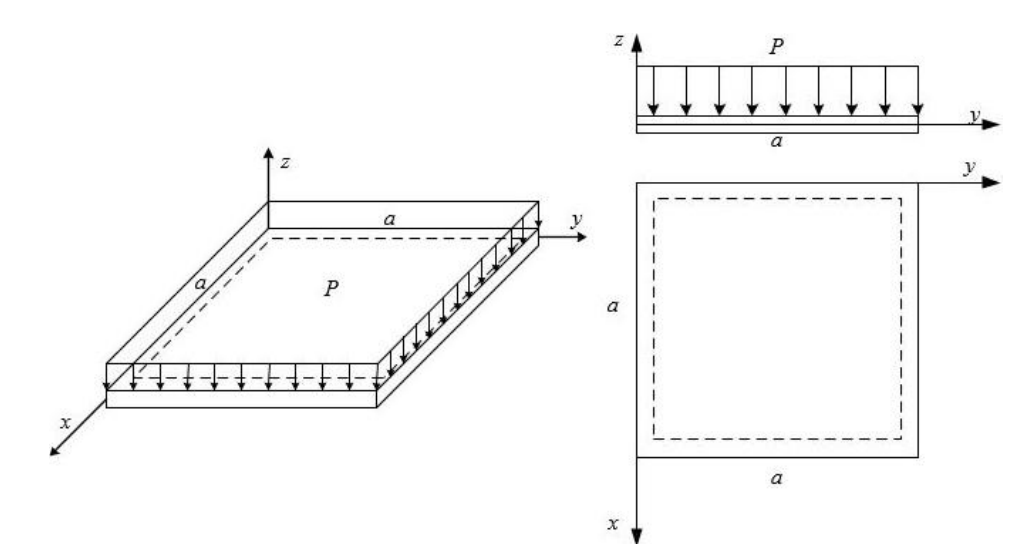
Figure 2. Schematic representation of coordinate system, loads, and supports applied to the plate. The plate domain was discretized using 17 × 17 Lagrangian four node elements (Q4) and nine node elements (Q9), and the plate was submitted to a constant unit pressure of 10 4 Pa. The study was conducted for three aspect ratios ( a / h = 5, 10, and 20, where ( a ) is the plate edge dimension ( a = 1 m), and ( h ) stands for the thickness. The power exponent p used, was 7. The results obtained are presented in Table 1 in a non-dimensional form using the multiplier w ndim = w max / h , where w max is the maximum deflection. Table 1. Non-dimensional maximum deflection w ndim and deviation. Power law functionally graded materials (FGM). a / h